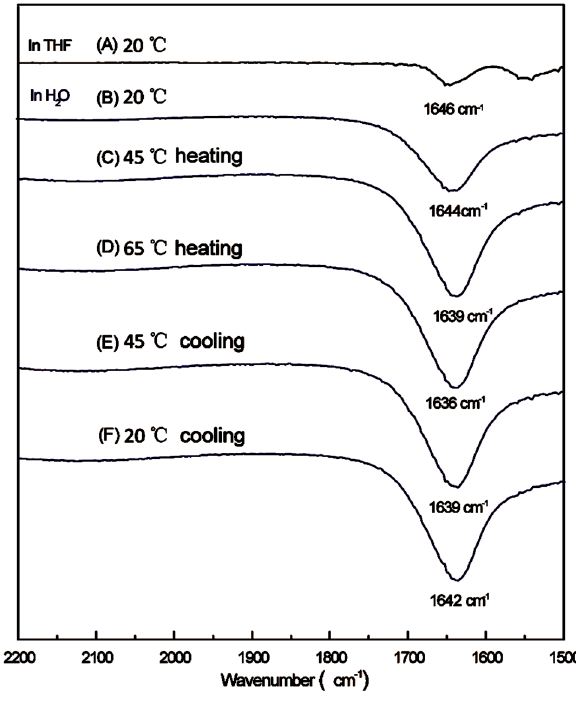
Figure 6. ATR-FTIR spectra of LCHBPNIPAM in THF ( A ) and in H 2 O at different temperatures ( B – F ) (( B ) 20 °C; ( C ) 45 °C (heating); ( D ) 60 °C (heating); ( E ) 45 °C (cooling); and ( F ) 20 °C (cooling)) .